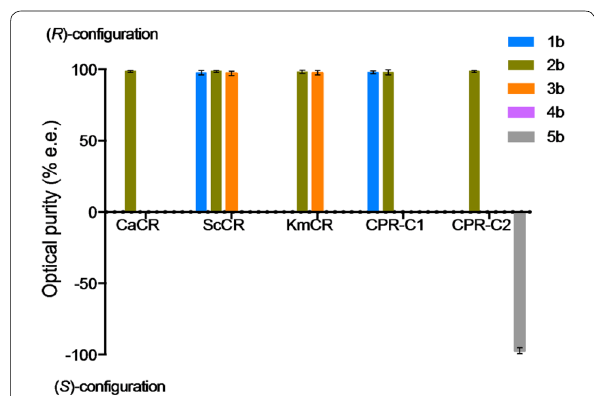
Fig. 5 Enantioselectivity of recombinant enzymes towards the carbonyl substrates. The configurations of the products, including (1b) methyl 2-hydroxy-2-phenylacetate, (2b) ethyl mandelate, (3b) ethyl 2-hydroxy-4-phenylbutyrate, (4b) 3-hydroxy-3-phenylpropionate, and (5b) N -benzyl-3-pyrrolidinol were analyzed as described in Table